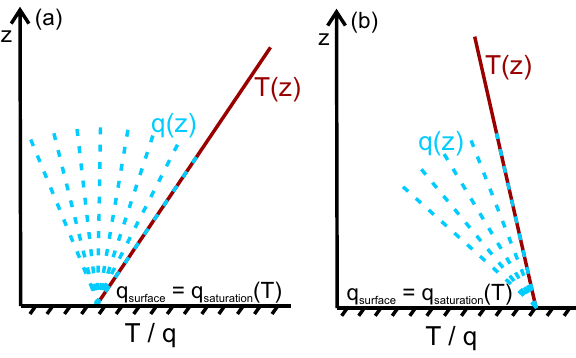
Fig. 10. Schematic presentation of potential profiles of specific hu- midity for two cases of air temperature profiles: (a) when a surface- based temperature inversion is present, a surface-based humidity in- version can occur. On the other hand, (b) when there is no surface- based temperature inversion, a surface-based humidity inversion cannot